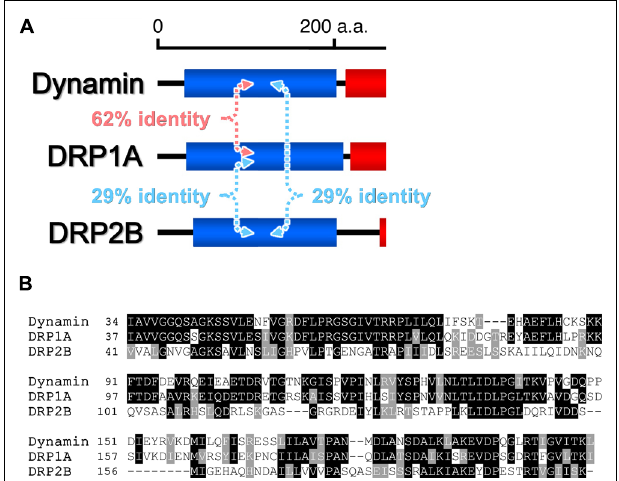
FIGURE 2 | Comparisons of the amino acid sequences of the GTPase domains of H. sapiens dynamin and Arabidopsis thaliana DRP1A and DRP2B. (A) Pairwise amino acid sequence identities. (B) Clustal alignment of the sequences. Identical and similar amino acid residues are outlined in black and gray,